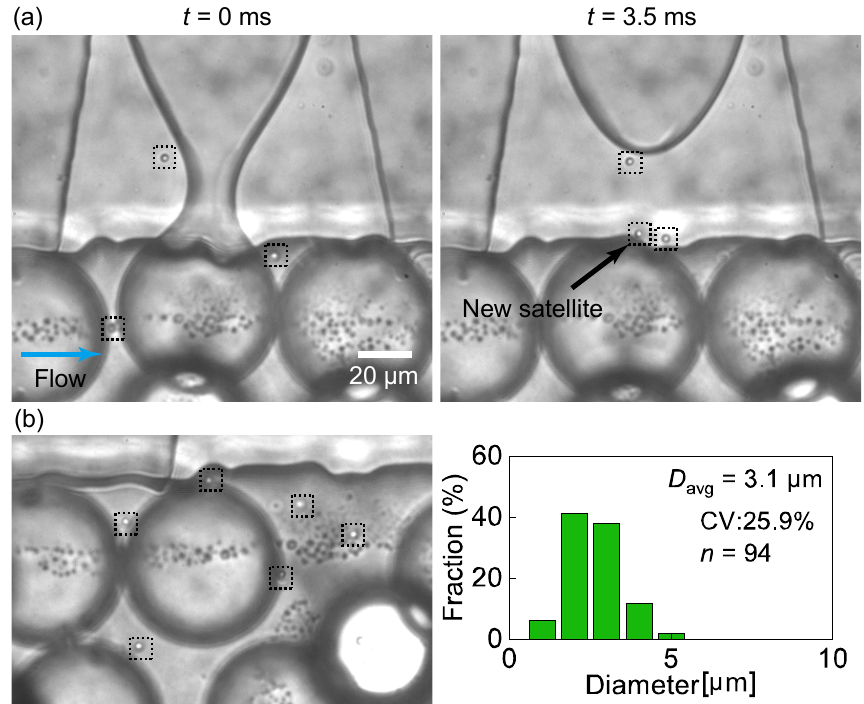
Figure 3. Formation of satellite droplets. ( a ) Snapshots of the satellite droplets (in the dashed squares) around a nozzle taken before ( t = 0 ms) and after ( t = 3.5 ms) the break-off of a main droplet. ( b ) Satellite droplets flowing around the nozzle edge and their size distribution. Flow rates were Q d = 0.1 mL/h and Q c = 10.0 mL/h.